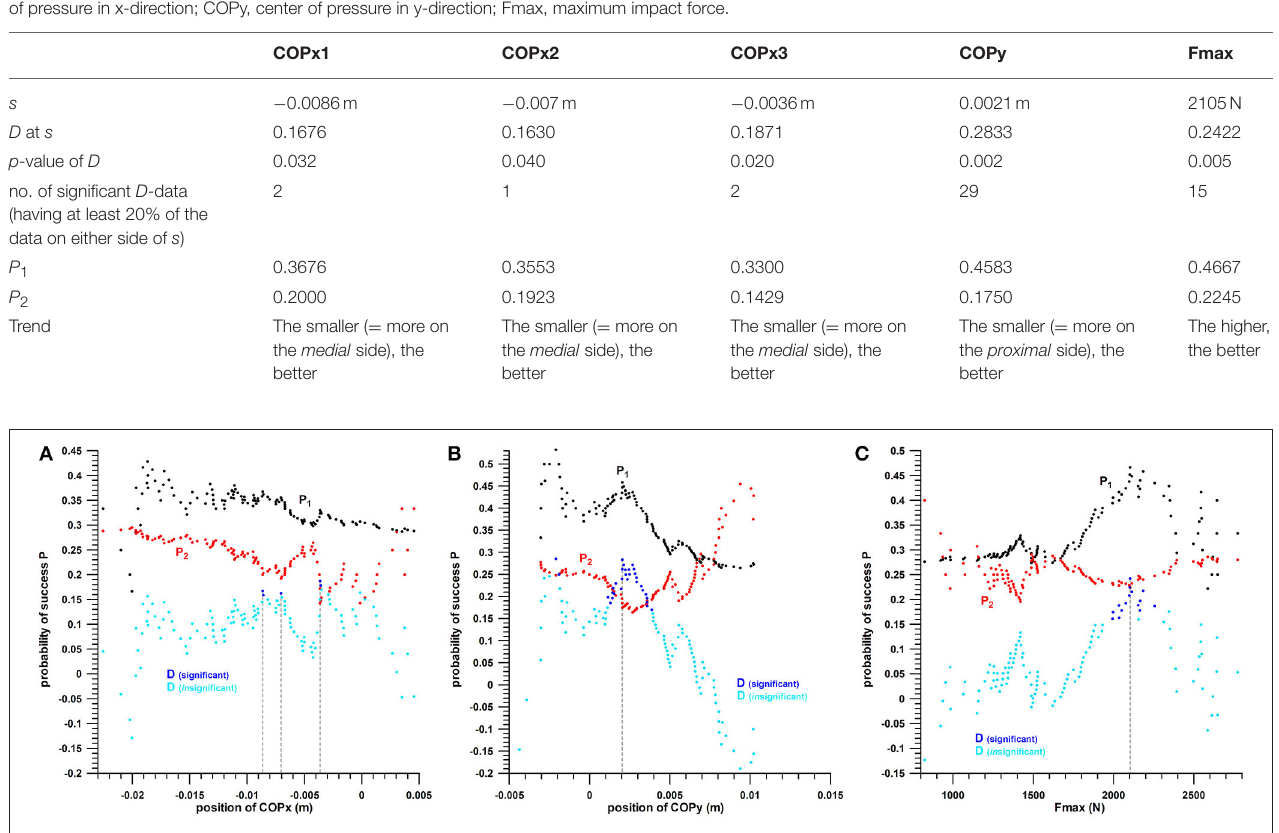
FIGURE 6 | Probability P of success of scoring a goal against the parameter range; P 1 = probability of scoring a goal if the parameter is in the favorable range; P 2 = probability of scoring a goal if the parameter is in the unfavorable range; D = differential of P 1 and P 2 ; (A) : P against COPx (location of the COP in x-direction); (B) : P against COPy (location of the COP in y-direction); (C) : P against Fmax (peak impact force); note that D can be negative, if P 2 > P 1 .